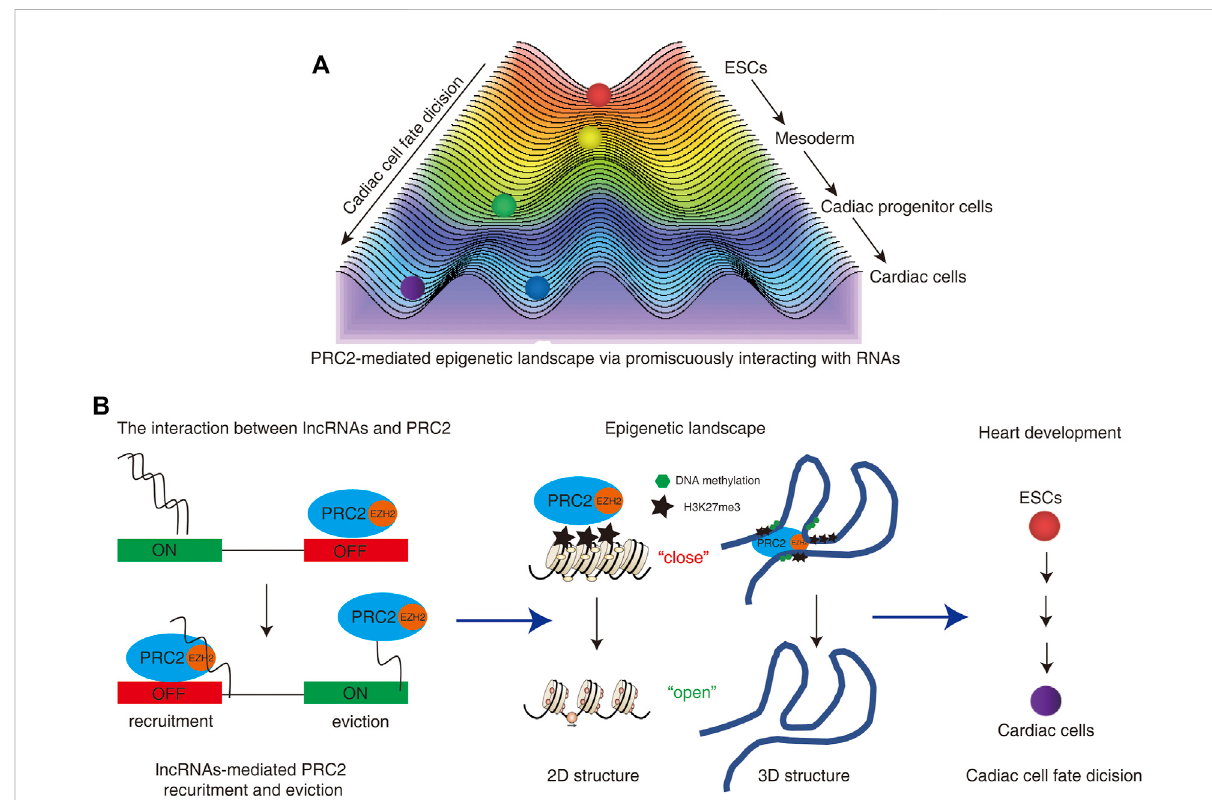
FIGURE 1 (A) PRC2-mediated epigenetic landscape controls cardiac cell fate decision. Stem cells are reimagined as pebbles on the top of a hill. During development,stem cells differentiate into differenttypesofcells as thepebbles rolldown from thetop. The fi nal differentiated cells are the cell fates of these cells. Epigenetic-paved pathways like small paths on a hill decide the destination of these cells. (B) The interactions between lncRNAs and PRC2 regulate the functions and occupies of PRC2 on the genomes. The dual roles of PRC2-RNA interaction regulate the recruitments and/or evictionofPRC2fromthegenome,whichfurther “ turnon ” or “ turnoff ” thegeneexpressions.ThedistributionofPRC2couldinducetheformationof heterochromatinorheterochromatin-likestructures via depositionofrepressedhistonemodi fi cationmarkerH3K27me3onthe2Dand3Dgenome. The dynamic changes of PRC2-mediated epigenetic landscape decide the cardiac cell fate and regulate heart